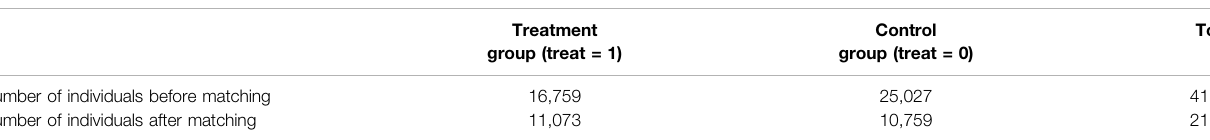
TABLE 6 | Sample distribution table before and after